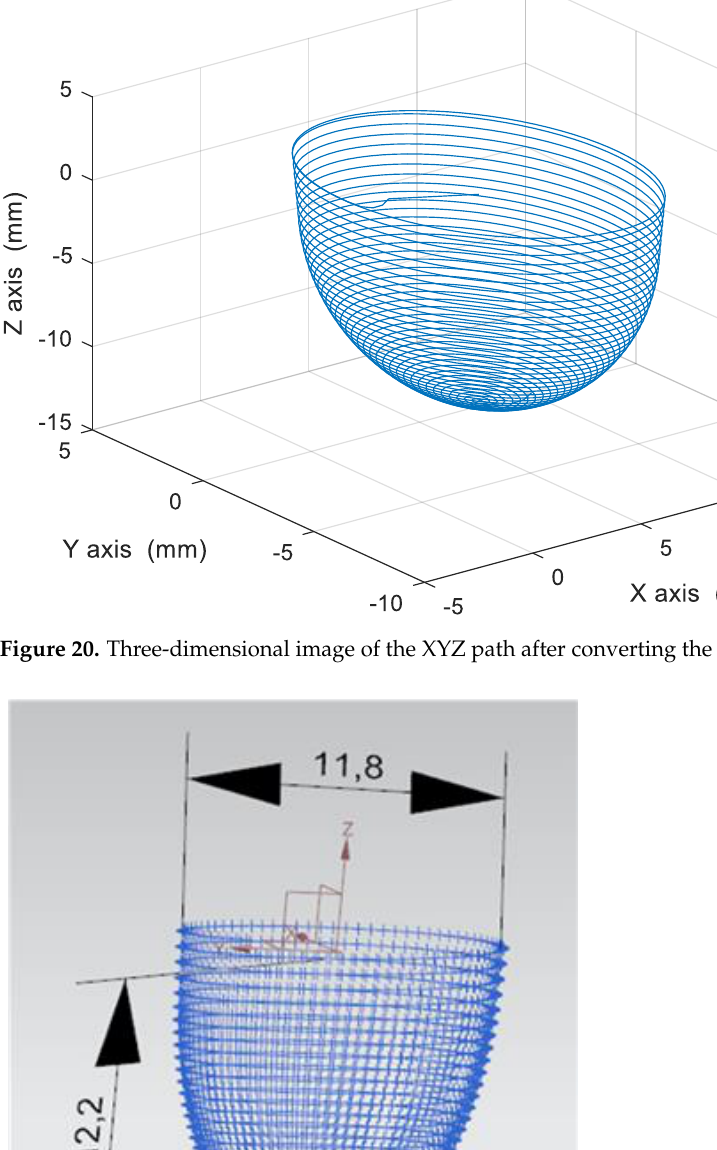
Figure 19. The lengths of the parallel three-axes after converting the rough machining program.